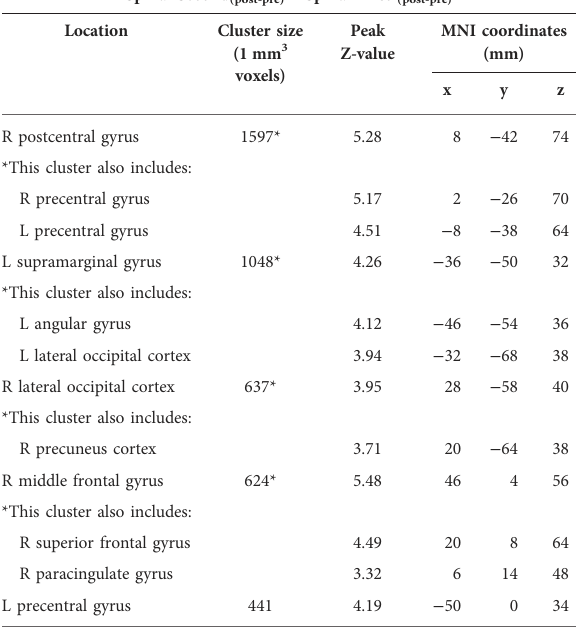
Signi fi cant clusters of brain response to spinal anesthesia (Second versus First) signi fi cant at p <0.05 cluster corrected. A Z-threshold of 3.1 was used; L=Left; R=Right.